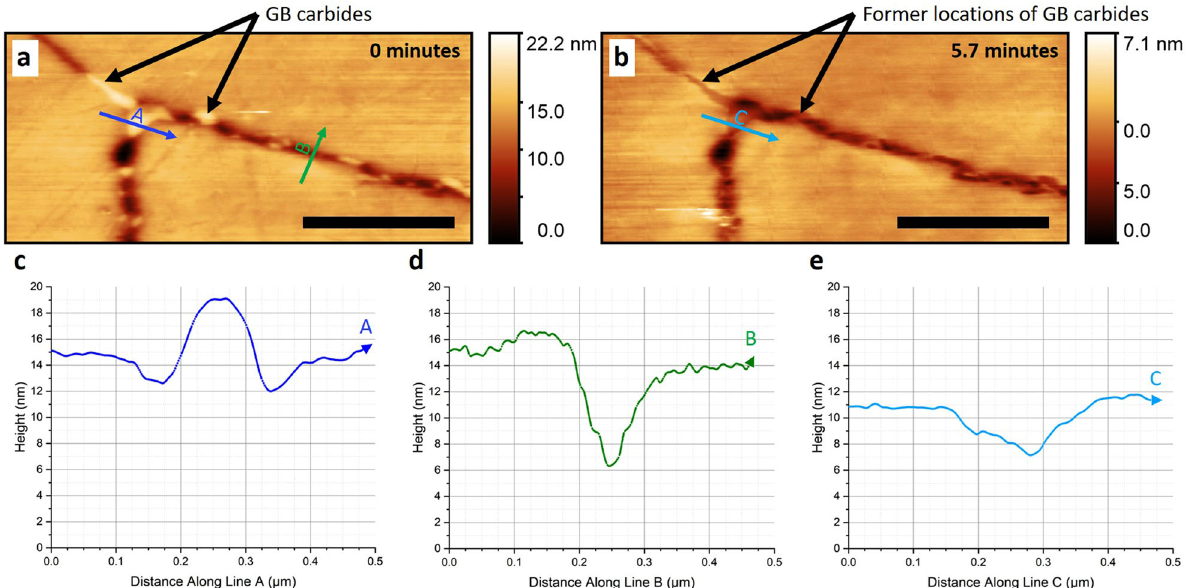
Fig. 2 In situ HS-AFM measurements of localised corrosion. Images show HS-AFM topographic maps from a time-lapse of thermally sensitised AISI Type 304 stainless steel undergoing corrosion within 395 mg L − 1 aqueous sodium thiosulfate at: a 0 min (scale bar: 1 µm), and ( b ) 5.7 min (scale bar: 1 µm). Each topographic image was collected over 0.5 s. Also shown are line pro fi les of height changes collected across: ( c ) Line A indicated in ( a ) as a dark blue line, d Line B indicated in ( a ) as a green line, e Line C indicated in ( b ) as a light blue line. Height measurements have an error of ±15